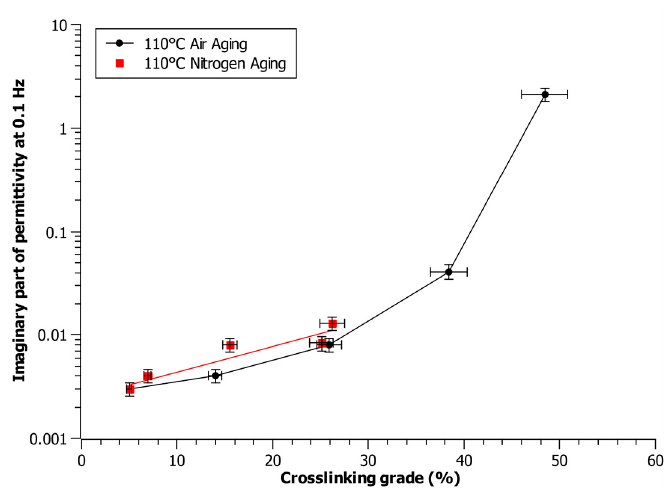
Figure 6. Crosslinking grade as a function of the imaginary part of permittivity at 0.1 Hz for 110 °C in air and under nitrogen aging.